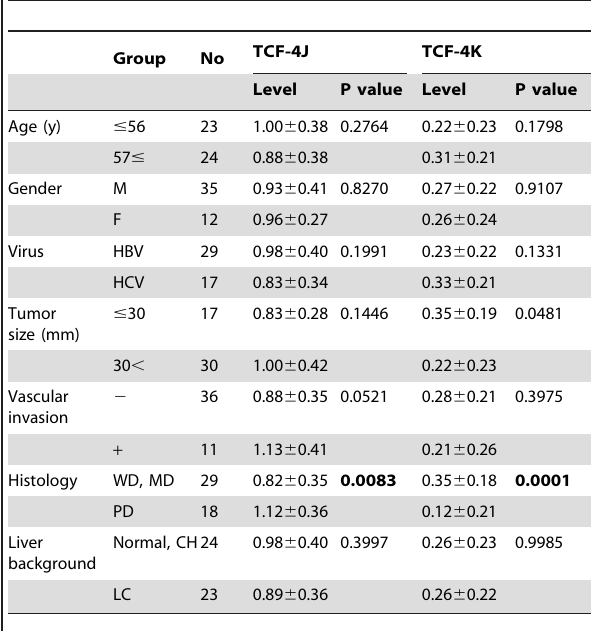
Table 3. Relation between clinicopathological factors and TCF-4J and K expression in